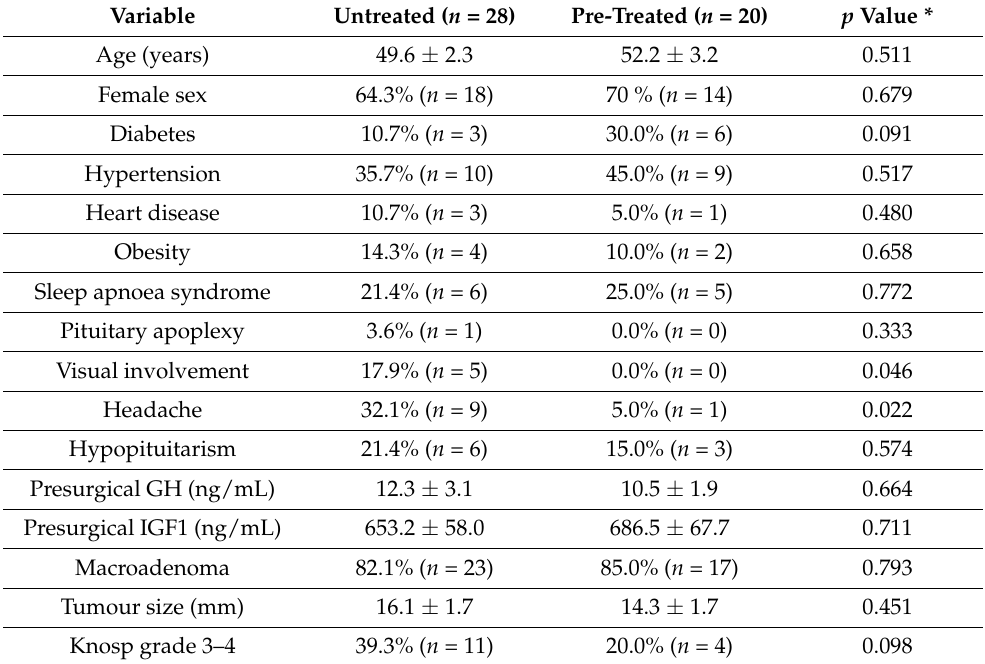
Table 1. Baseline characteristics of patients pre-treated with somatostatin analogues and